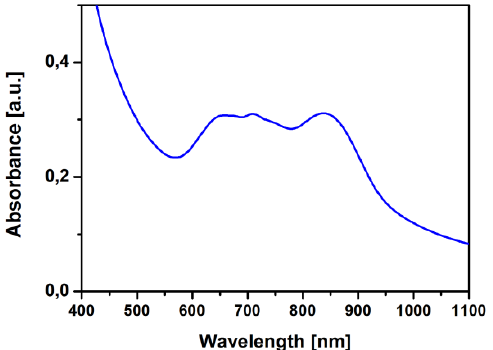
Figure 4. UV-Visible absorption spectra of TiOPc film deposited by Vapor Phase Deposition, showing the typical phase II